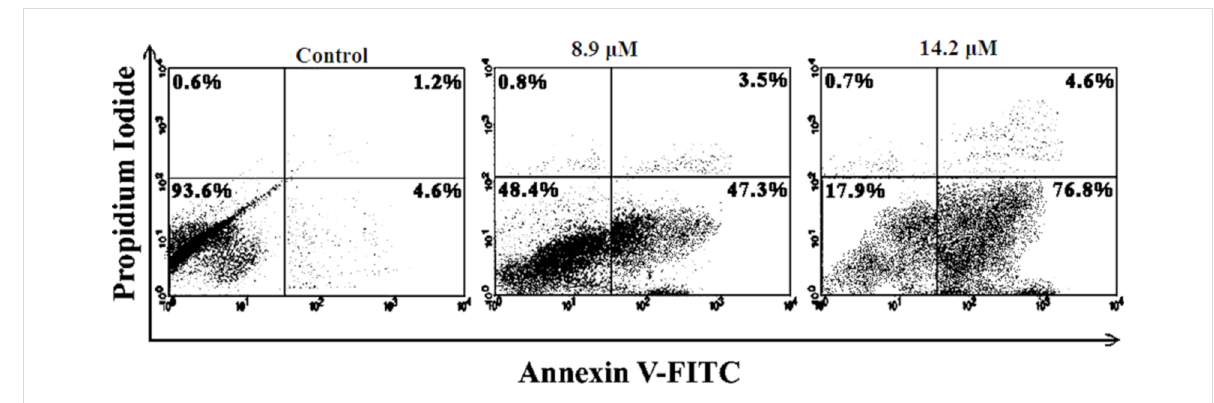
Figure 5: The quantitative results of bivariate FITC-Annexin V/PI FCM of HeLa cells after treatment with 11b for different concentrations (at 8.9, and 14.2 µM, respectively).